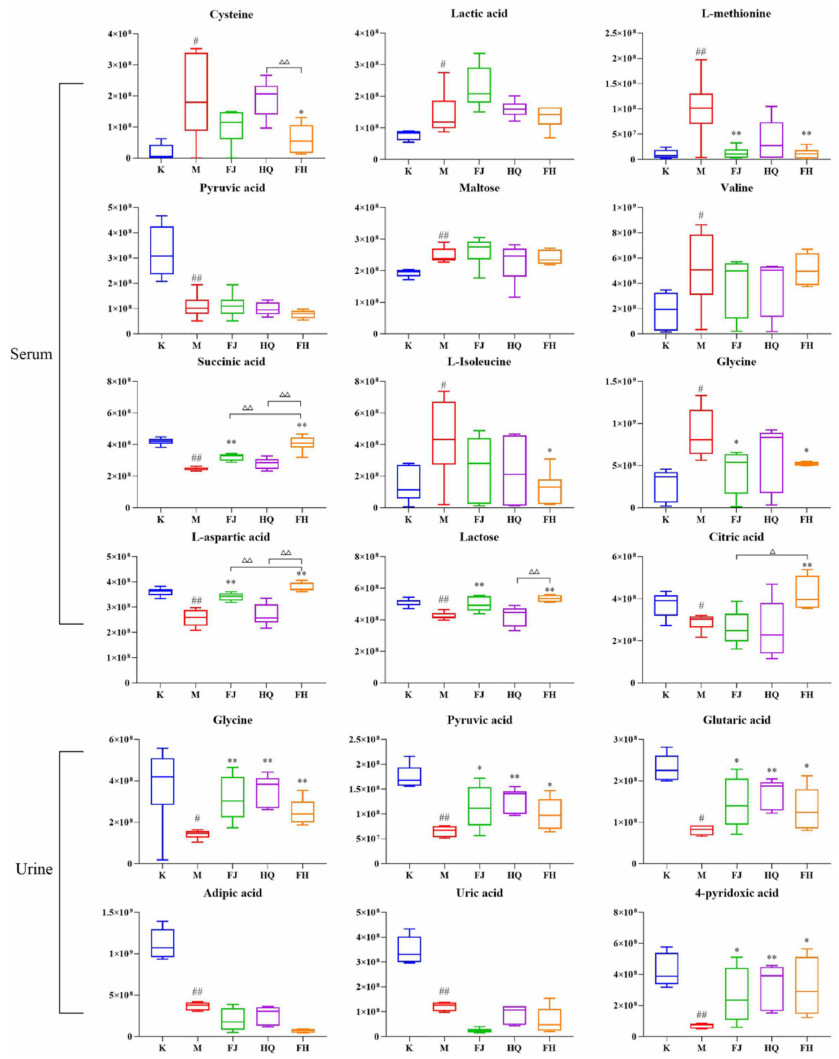
Figure 7. Expression levels of differentially expressed metabolites in serum and urine. Note: Com- pared with the K group, # p < 0.05, ## p < 0.01. Compared with the M group, * p < 0.05 and ** p < 0.01. Compared with FH group, (cid:52) p < 0.05, (cid:52)(cid:52) p <